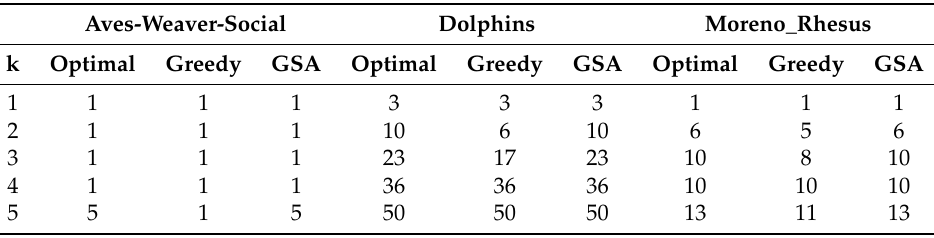
Table 7. Compare the optimal solution with the approximate